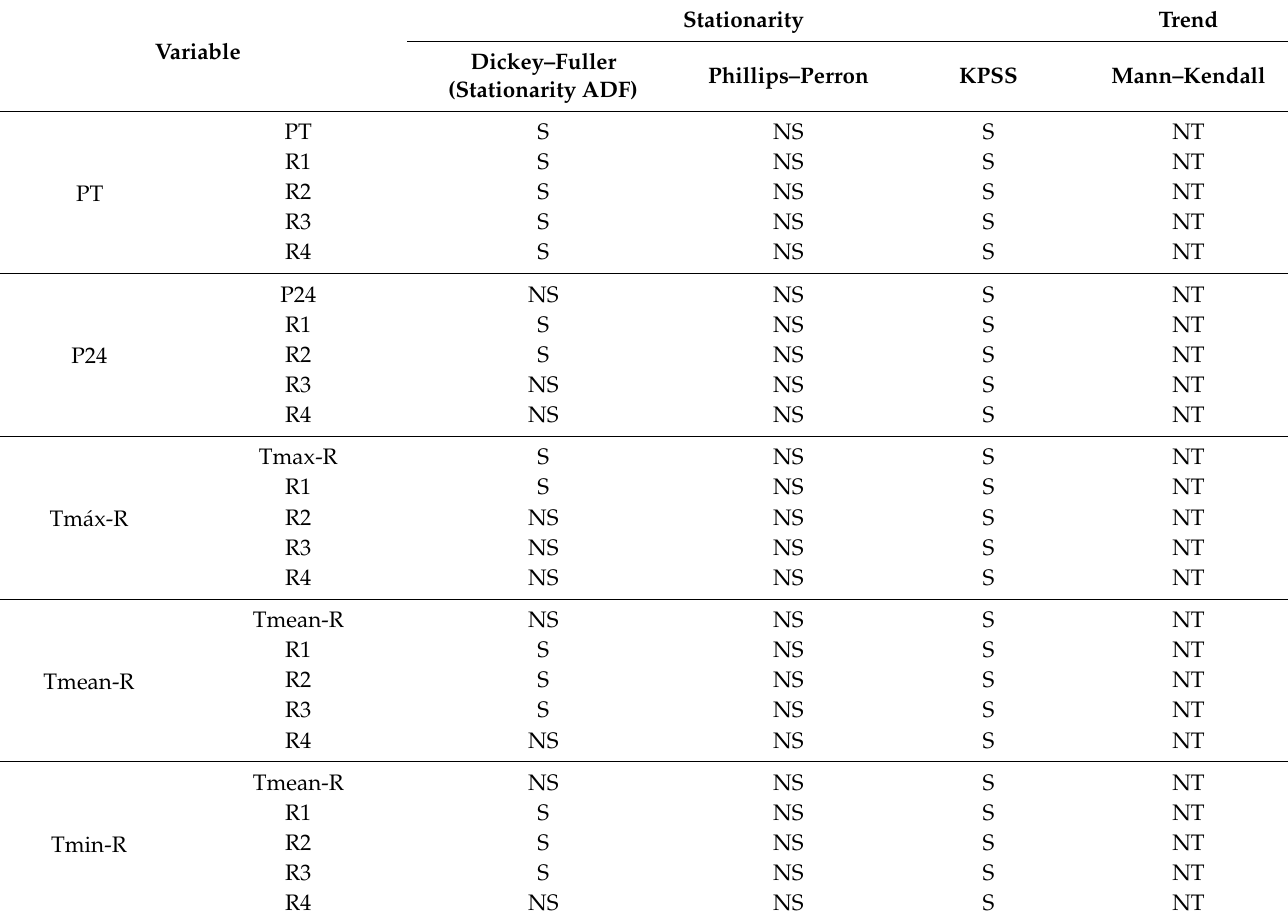
Table A1. Results of the stationarity and trend tests for the original series (PT, P24, Tmax-R, Tmean-R, and Tmin-R) and residuals (R1, R2, R3, and